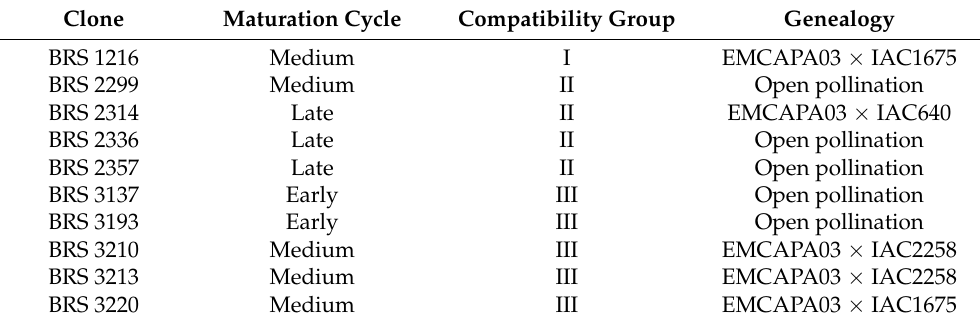
Table 2. Listing of the clones evaluated in clone competition trials evaluated in three environments of the Western Amazon: E1—Porto Velho dryland, E2—Ouro Preto do Oeste dryland, E3—Ouro Preto do Oeste